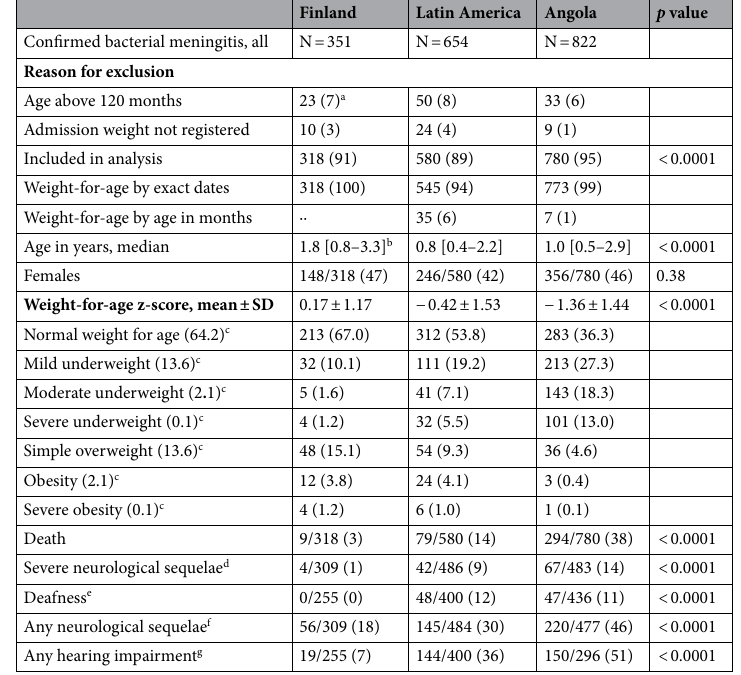
Table 1. Patient characteristics. a In parentheses, percentage. b Interquartile range. c Expected proportion in a normal distribution of z-scores of weight-for-age. d Blindness, quadriplegia/paresis, hydrocephalus requiring a shunt, or severe psychomotor retardation. e Hearing threshold in the better ear ≥ 80 dB. f Severe neurological sequelae, or moderate psychomotor retardation, hemiparesis, monoparesis, or ataxia. g Hearing threshold > 40 dB in either